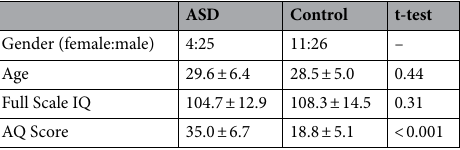
Table 1. Demographic information of the ASD and control groups (shown as mean ± standard deviation).